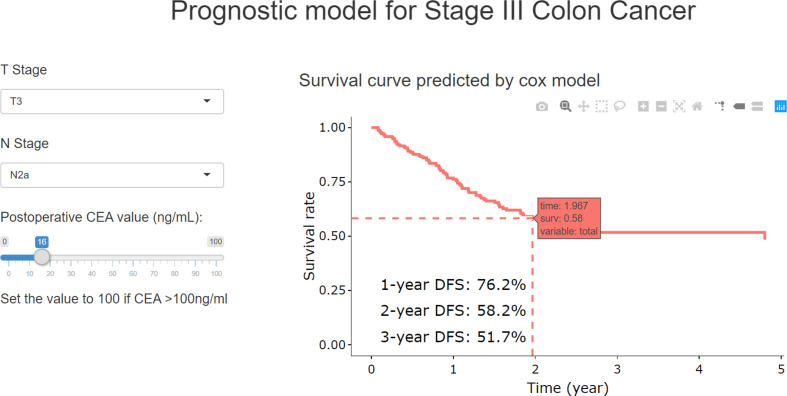
The online web-tool for the TN-CEA model.